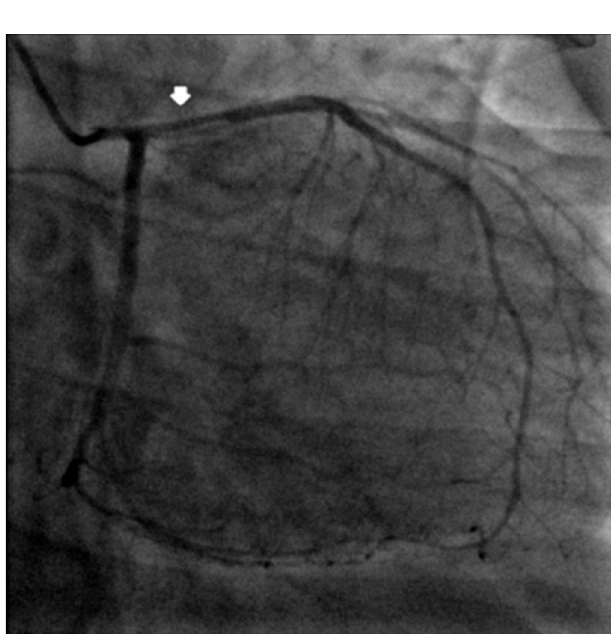
Fig. 1 – Spontaneous coronary artery dissection of the left anterior descending coronary artery (arrow).